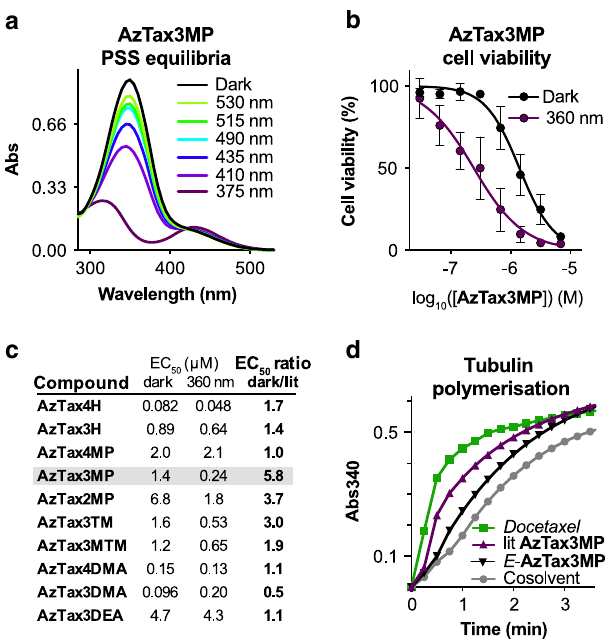
Fig. 2 Photoswitchable performance of AzTax. a Photostationary state UV – Vis absorption spectra of AzTax3MP under a range of cell-compatible wavelengths similar to microscopy laser lines. b, c Resazurin antiproliferation assays of AzTax highlight their structure- and light- dependent cell cytotoxicity. HeLa cells, 40 h incubation in dark conditions (all- E ) or under pulsed illuminations with low-power LEDs (75 ms per 15 s near-UV at < 1 mWcm -2 ; lit = ~80% Z) (dose-response curves are fi tted to the means (shown with s.d.) of 3 independent biological experiments). d A cell-free assay for polymerisation of puri fi ed tubulin comparing the MT stabilisation activity of docetaxel, all- E - and 360 nm-lit- AzTax3MP (all 10 µ M) shows light-speci fi c promotion of polymerisation by Z- AzTax3MP , matching the trend observed in cellular